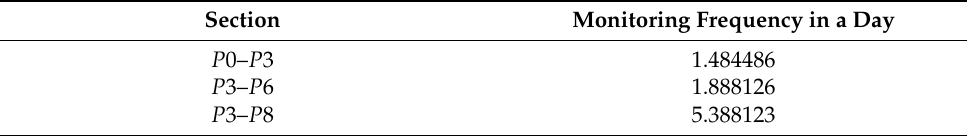
Table 4. Monitoring frequency in a day.